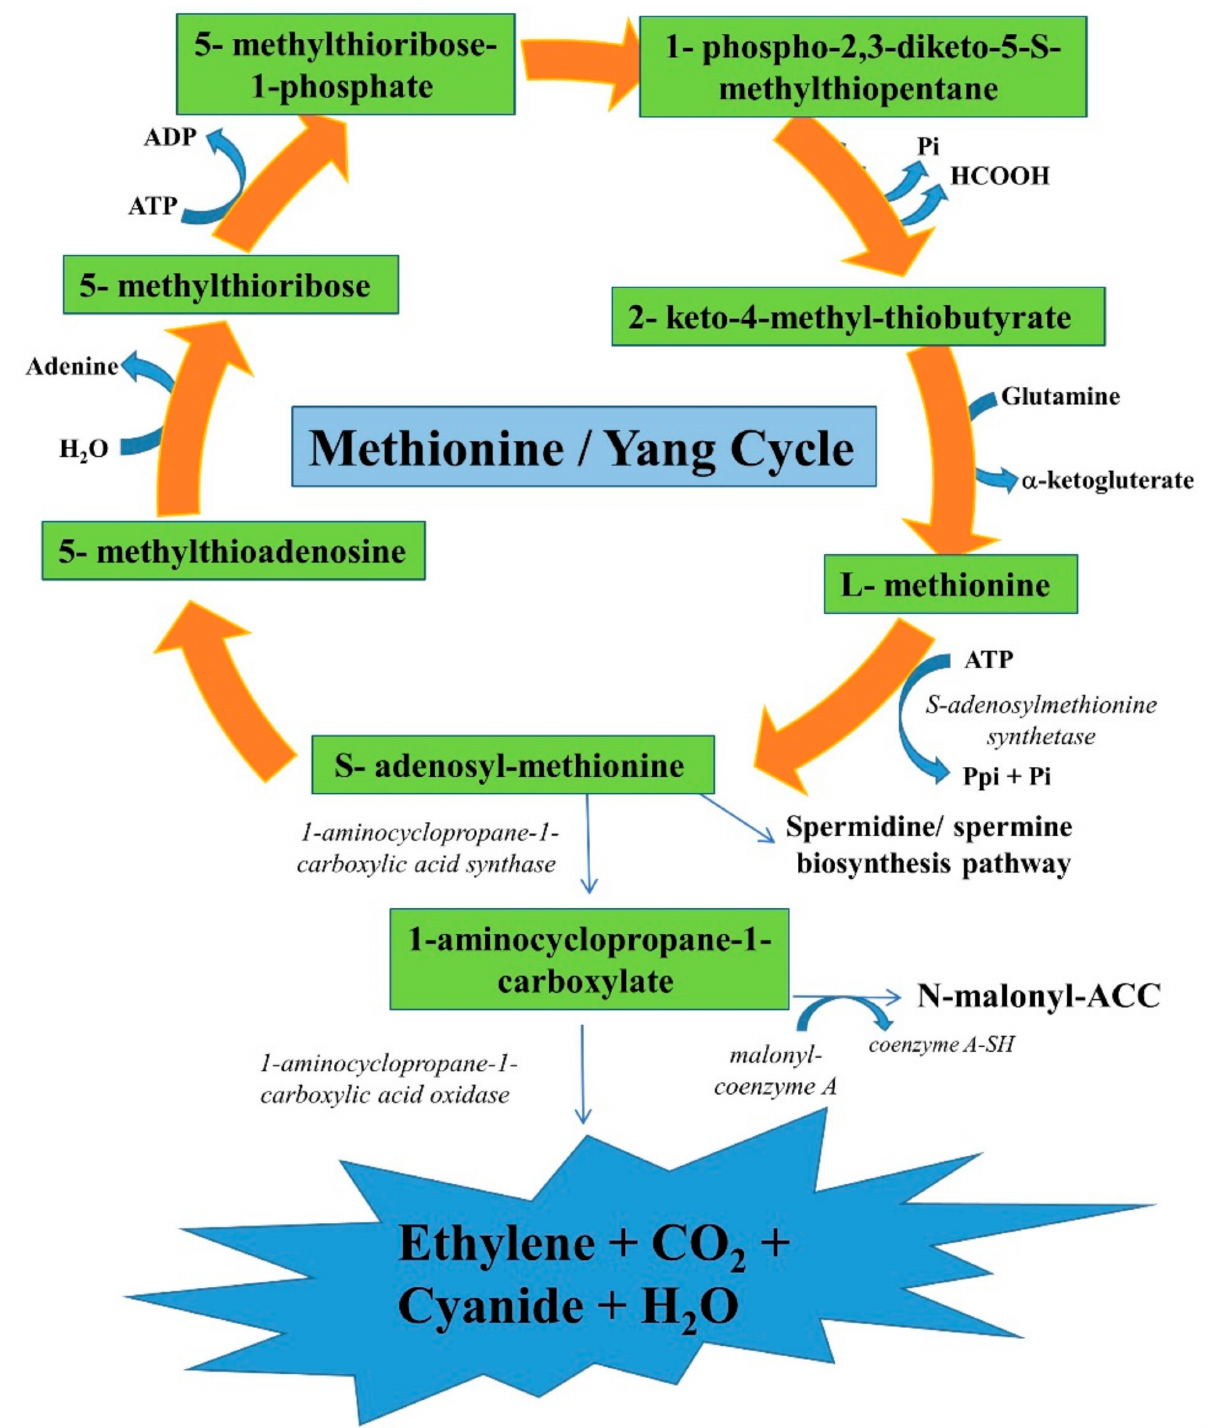
Figure 1. Ethylene biosynthesis with the methionine precursor and the intermediate synthesized as 1-aminocylopropane-1-carboxylic acid (ACC) in higher plants through the Methionine/Yang cycle. Ethylene biosynthesis is the conversion of S-adenosyl-methionine (SAM) from methionine to ACC by ACC synthase (ACS). Methionine is reproduced within the Yang cycle. The Yang cycle is a set of reactions that recycle 5-methylthioadenosine to